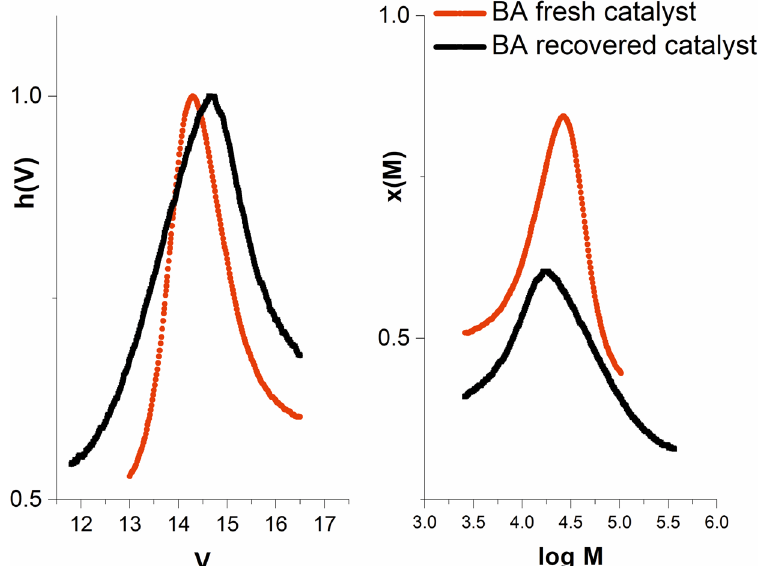
Figure 3. GPC traces for BA-fresh catalyst and BA-recycled